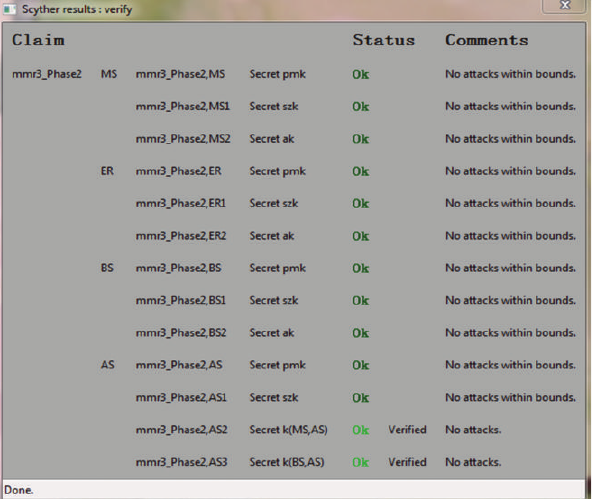
Figure 9: Verification result for Protocol 3-Phase 2, initial authen- tication.